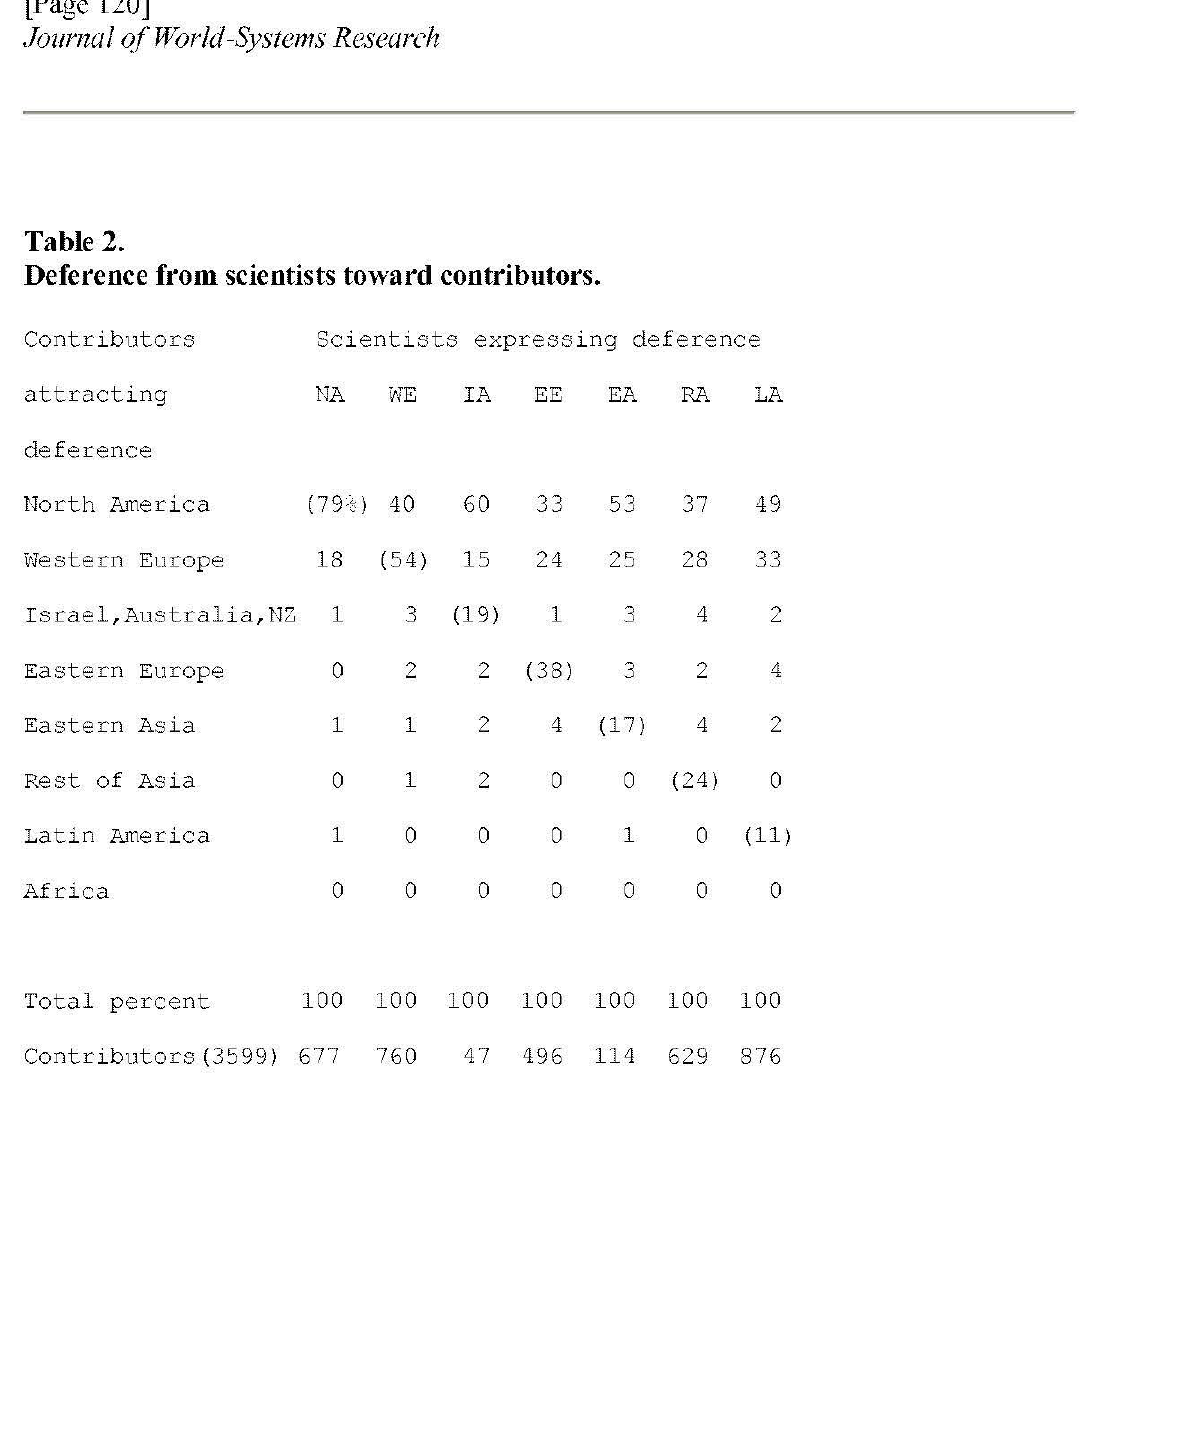
Table 2. Deference from scientists toward